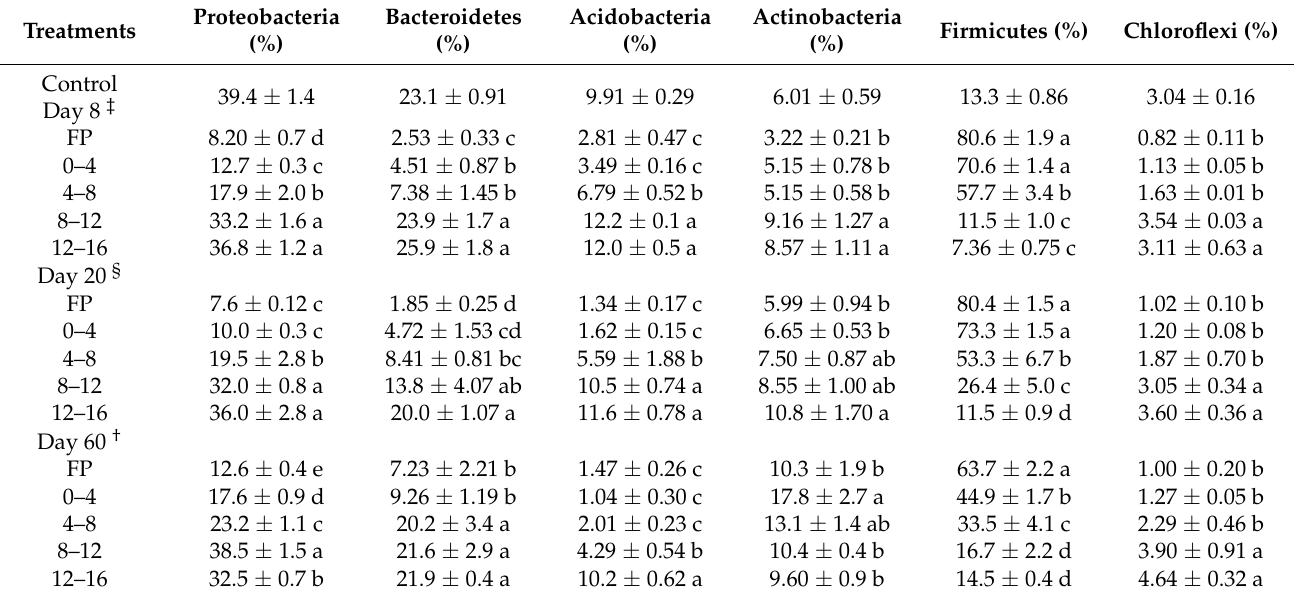
Different letters in the same column for each treatment indicate significant differences according to one-way ANOVA (LSD, p < 0.05) when comparing treatments within the same incubation time. Control: samples at Day 0 (pre-culture and pre-incubation). ‡ : Day 8, samples at 8 days after urea application. § : Day 20, samples at 20 days after urea application. † : Day 60, samples at 60 days after urea application.